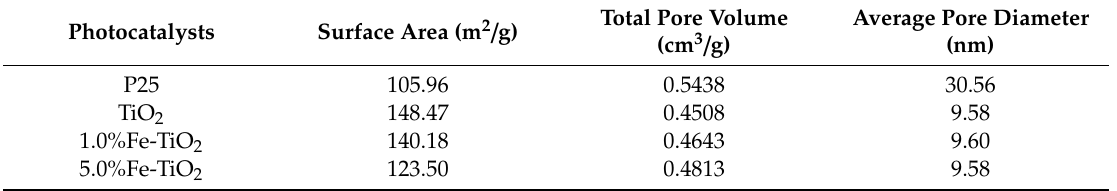
Table 2. Surface area, total pore volume and average pore diameter of